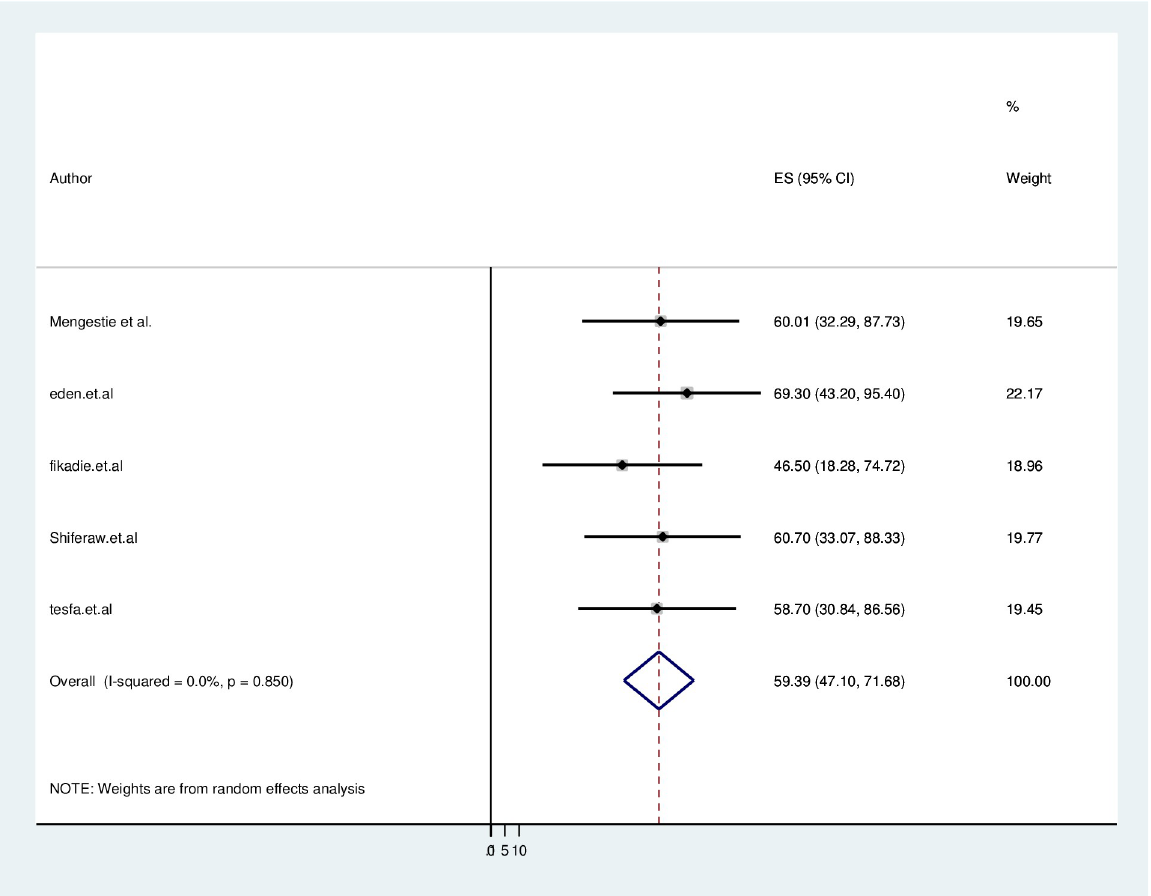
Fig 2. Forest plot showing the pooled prevalence of eHealth literacy in Ethiopia in